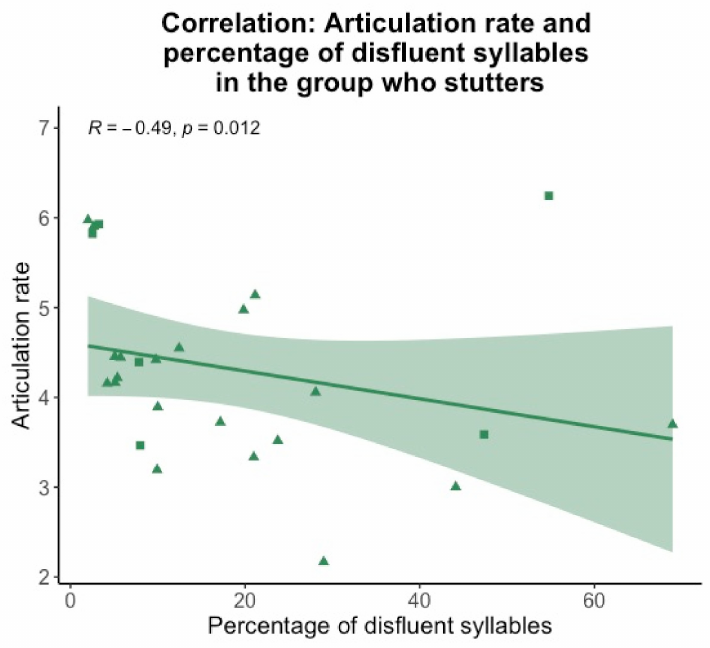
Figure 4. Spearman-rho correlation for the articulation rate (y-axis) and percentage of disfluent syllables (x-axis) for the group who stutters. Triangles display participants who did not read with a fluency- shaping technique, squares display participants who did read with a fluency-shaping technique.